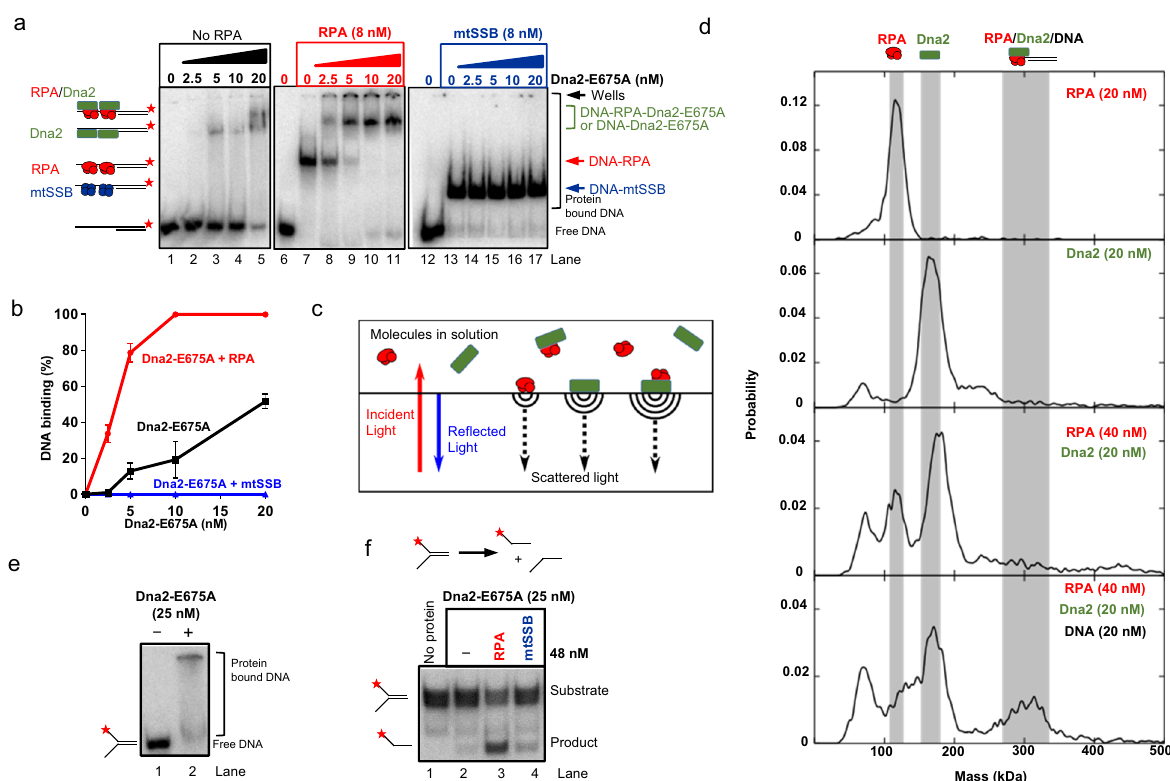
Fig. 2 RPA stimulates Dna2 beyond recruitment to DNA. a Representative electrophoretic mobility shift assays to monitor recruitment of Dna2-E675A to either free or RPA/mtSSB-precoated (8 nM) 5 ′ -overhanged DNA substrate (45 nt ssDNA, 48 bp dsDNA, 1 nM, in molecules) and with 150 mM NaCl. The red asterisk indicates the position of the radioactive label. b Quanti fi cation of assays such as shown in panel a . Error bars, SEM; n = 3. c A scheme of molecular weight determination using mass photometry. Scattered light from single adsorbed biomolecular complexes interferes with light re fl ected at the surface. The detected single-molecule interference contrast is proportional to the molecular weight. d Measured molecular weight distributions of RPA and Dna2 complexes in absence and presence of a 5 ′ -overhanged DNA substrate (25 nt ssDNA, 48 bp dsDNA, 20 nM, in molecules). For the formation of a heterotrimeric complex (panel at the bottom), RPA was added fi rst to the DNA followed by Dna2 addition. e DNA binding of Dna2-E675A to forked DNA (45 nt ssDNA, 48 bp dsDNA, 0.1 nM, in molecules) and with 50 mM KCl. One out of two independent experiments is shown. f Unwinding of forked DNA as in panel e by Dna2-E675A. DNA substrate was fi rst pre-bound by saturating concentrations of Dna2-E675A (25 nM) before adding yeast RPA or human mtSSB (both 48 nM) together with ATP and with 50 mM KCl. One out of three independent experiments is